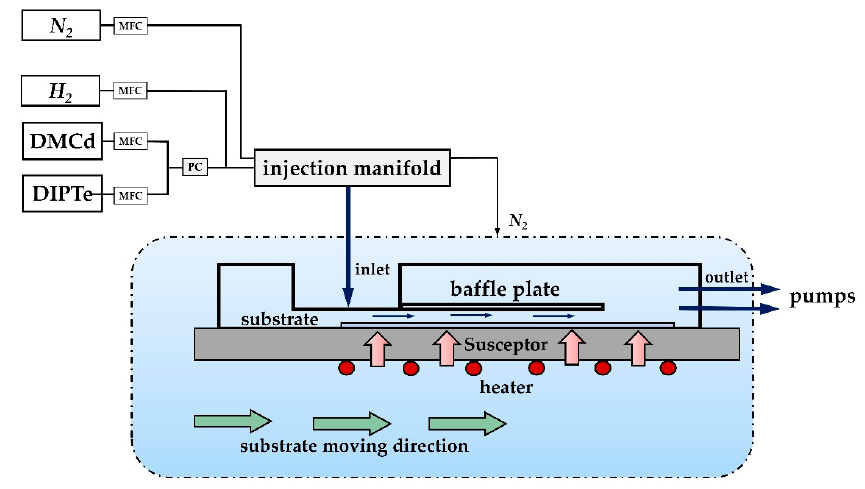
Figure 1. Experimental set-up for the inline deposition process of CdTe thin film.